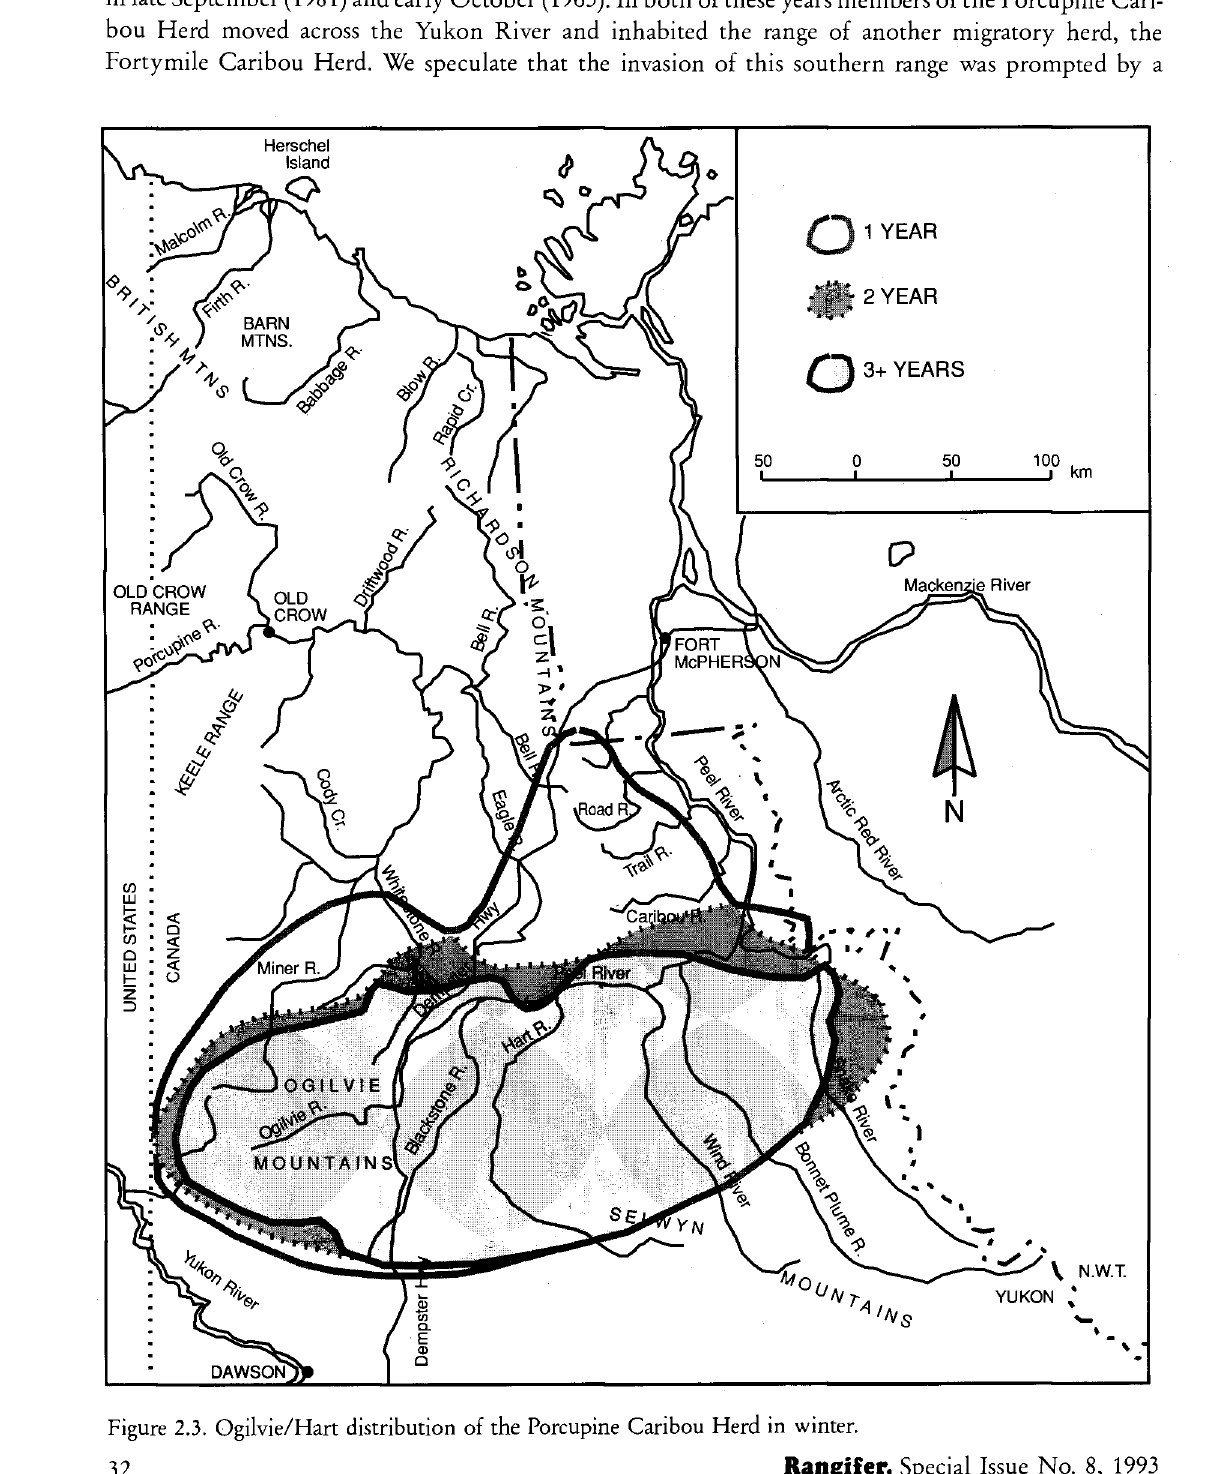
Figure 2.3. Ogilvie/Hart distribution of the Porcupine Caribou Herd in winter.